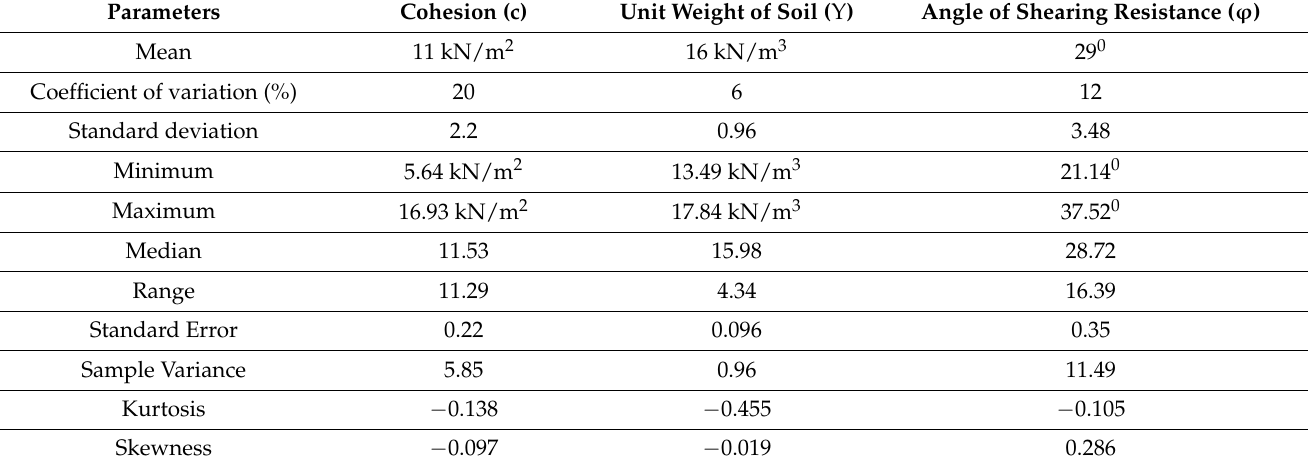
Table 1. Statistical depiction of dataset.